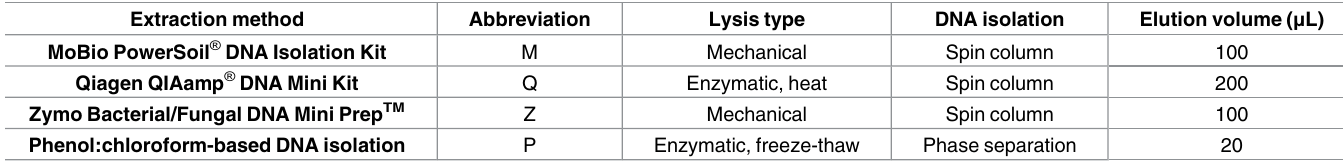
Table 1. Summaryof DNA extraction methods examined in this study. Extraction